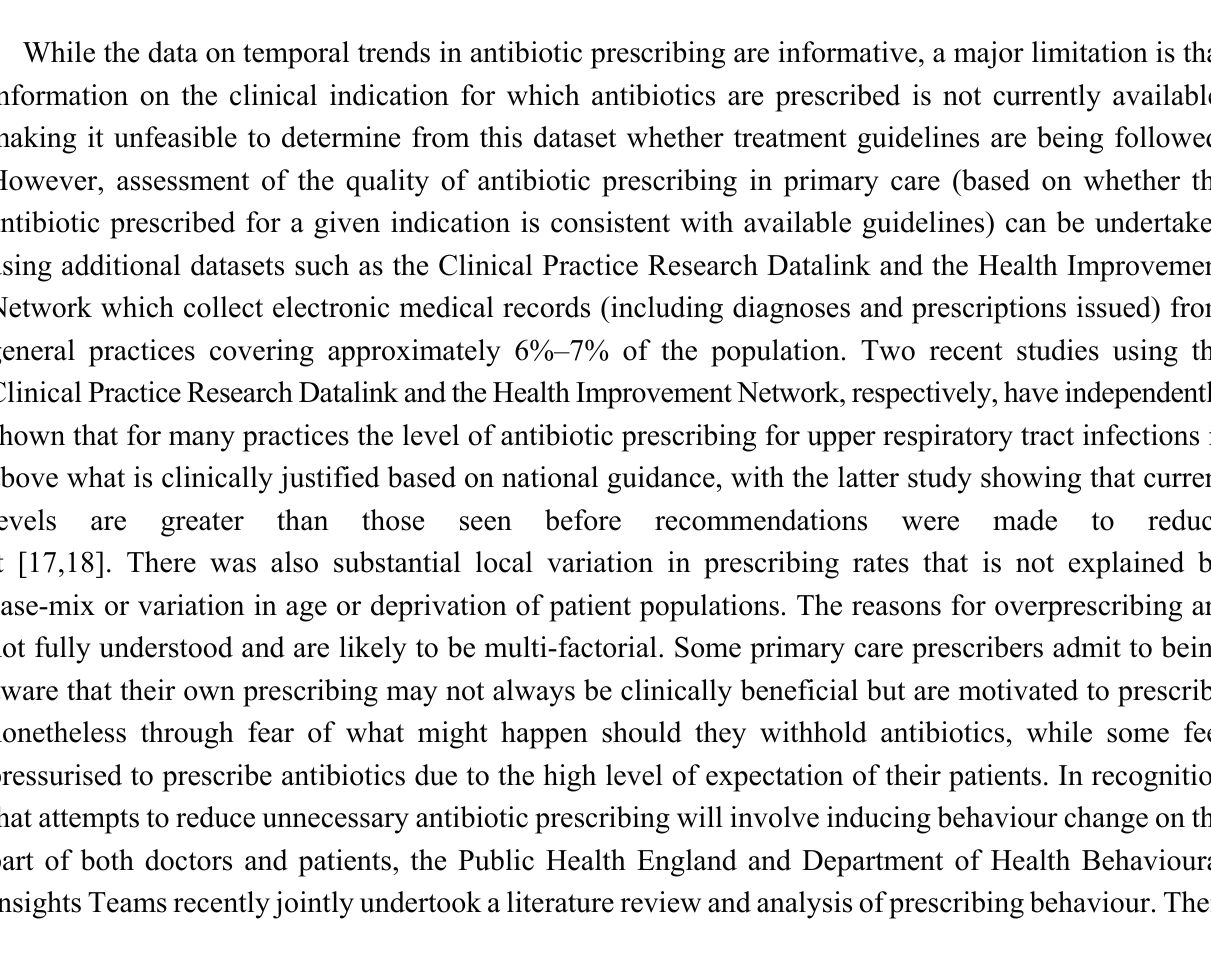
Figure 1. Scatterplot of antibiotic prescribing comparator values (MOKTT) for all 211 Clinical Commissioning Groups in England showing variation in antibiotic prescribing activity